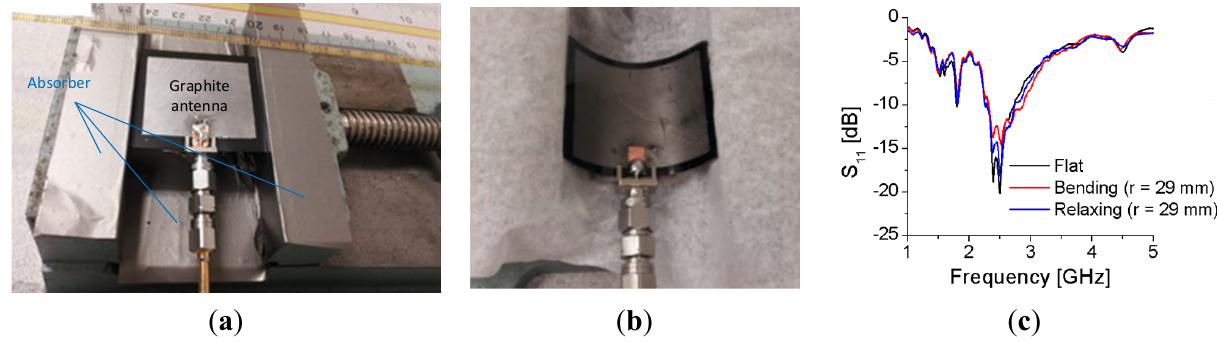
Figure 7. ( a ) Convex bending of graphite antenna; ( b ) Antenna is placed in the middle of test vice fixture; ( c ) Antenna response with convex bending of r = 29 mm (adapted from [17], Copyright 2013, permission granted by Kristen